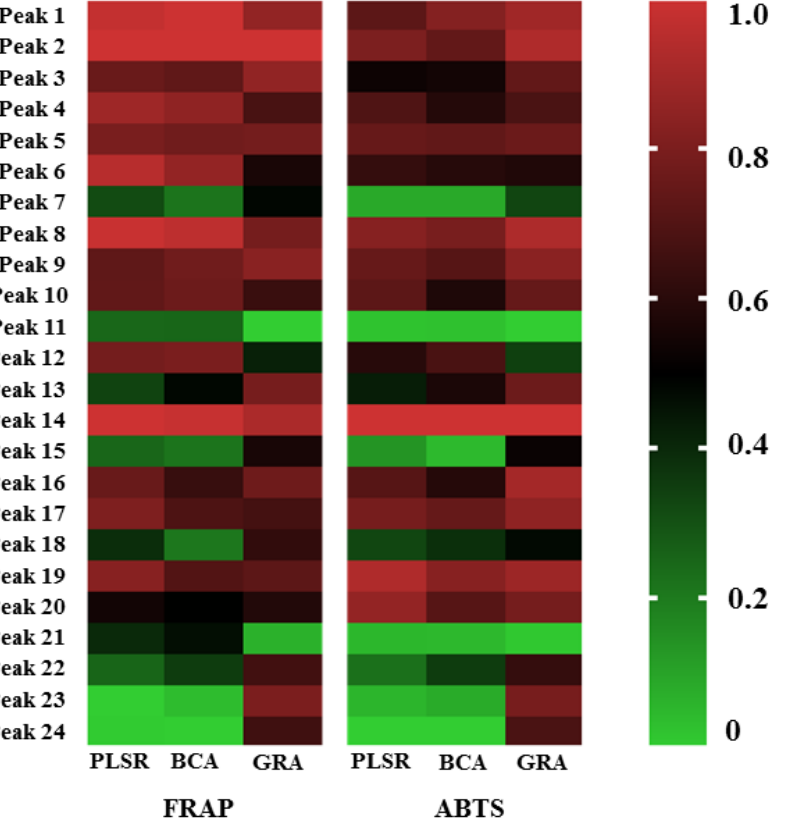
Figure 7. The heatmap of antioxidant correlation coefficient of 24 chromatographic peaks of different statistical methods.